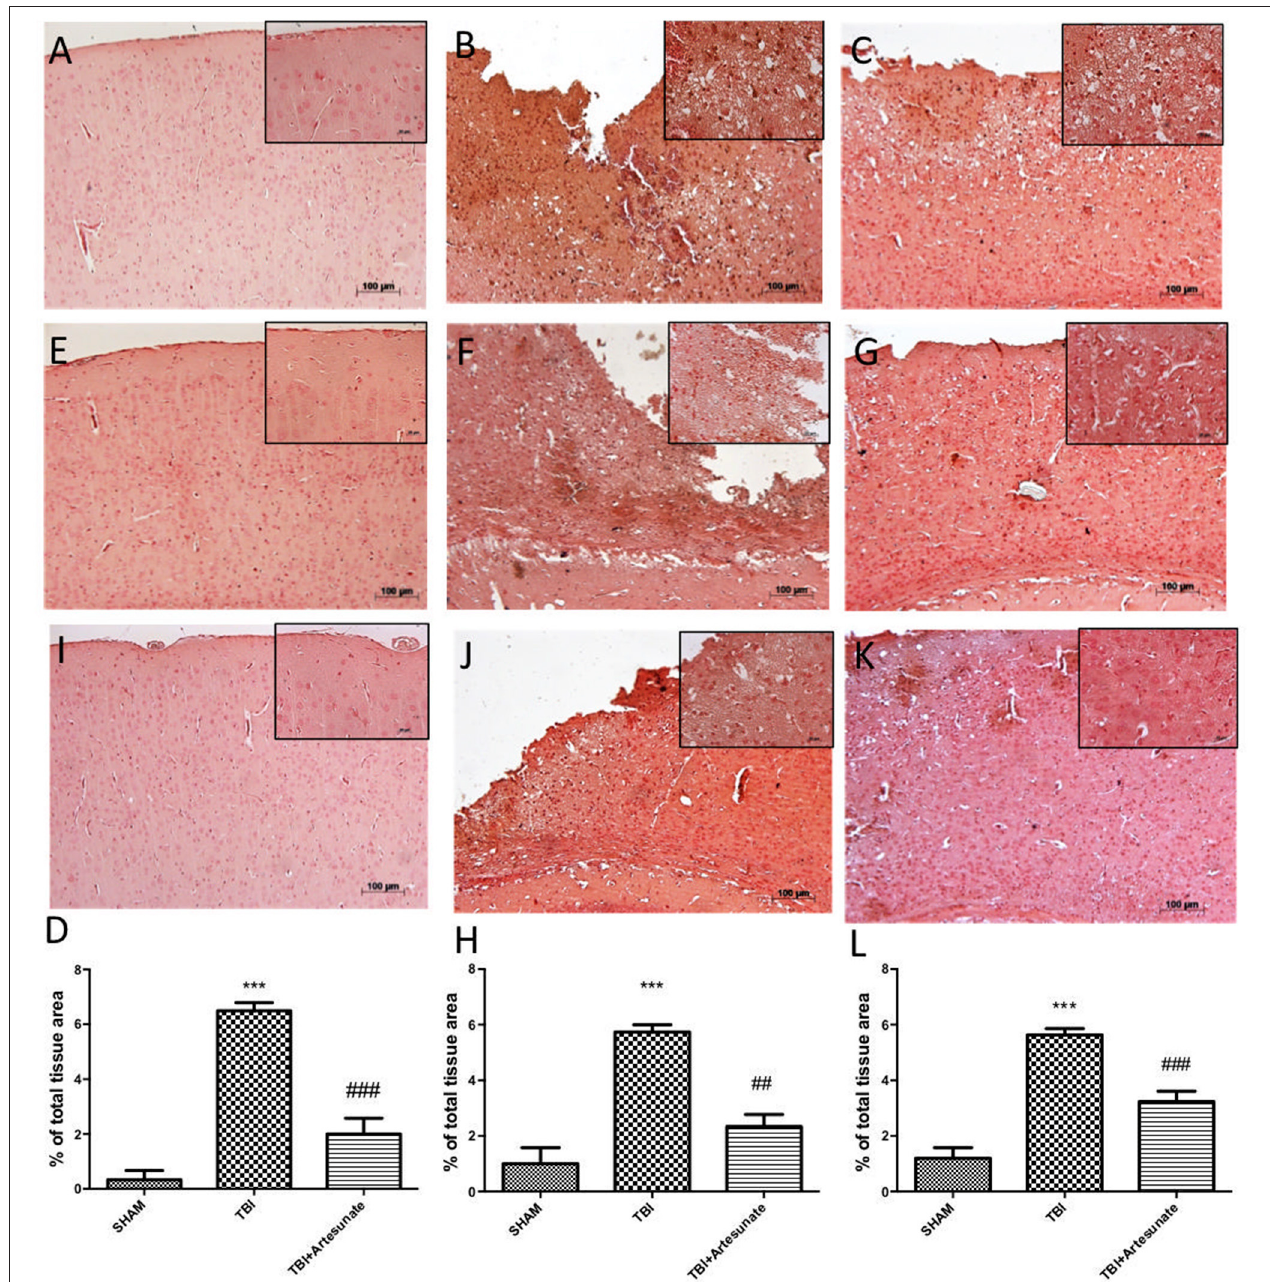
FIGURE 3 | Protective effect of artesunate treatment on cytokines and iNOS expression. (B,F) Showed a significant increase of expression for IL-1 β and TNF- α respectively, 24h after TBI injury compared with sham group (A,E) . When compared with vehicle group, brain section from mice treated with artesunate show a significant reduction in IL-1 β and TNF- α respectively (C,G) , see densitometric analysis (D) for IL-1 β , and (H) for TNF- α . The immunohistochemical analysis for iNOS, show that 24h after TBI injury in the vehicle group there is a significant increase in iNOS expression as show in (J) compared with sham group (I) . While as show in (K) treatment with artesunate significantly reduce the iNOS expression compared to vehicle group, see densitometric analysis (L) . Data are expressed as Mean ± SEM from N = 10 Mice for each group. *** P < 0.001 vs. corresponding sham group. ## P < 0.01 vs. respective TBI. ### P < 0.001 vs. corresponding TBI. ( F -value for IL-1 β = 57.84. df = 2. r 2 = 0.9507) ( F -value for TNF- α = 30.01. df = 2. r 2 = 0.9091) ( F -value for iNOS = 45.29. df = 2. r 2 = 0.883).